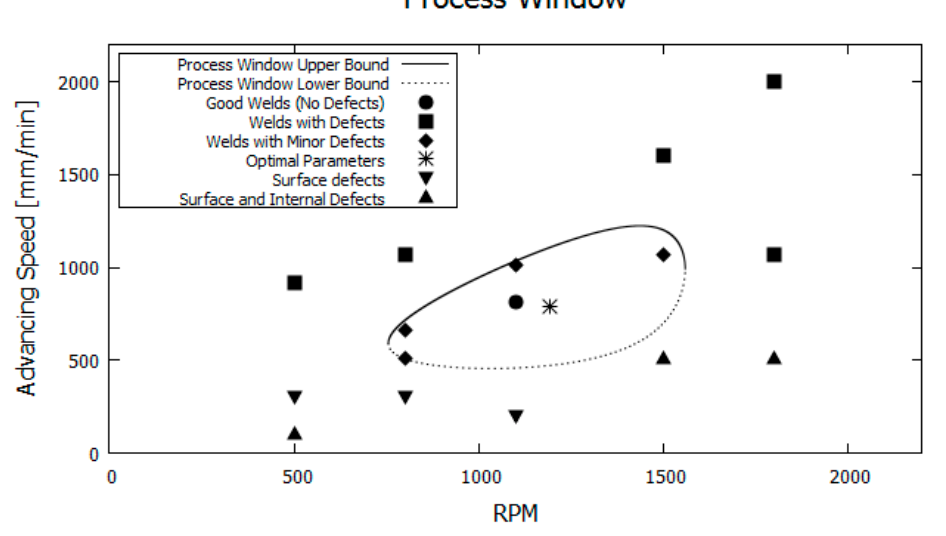
Figure 14. Process window.